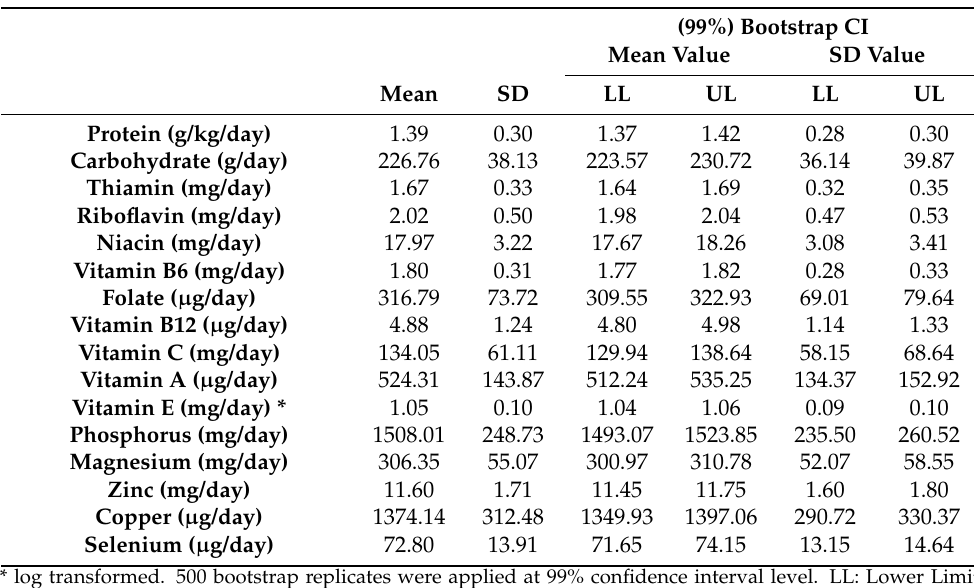
Table 4. Mean and standard deviation of usual intake of raw data used to derive bootstrap confidence intervals.